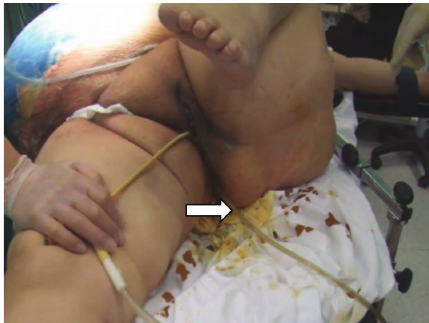
Figure 4: Intrarectal NPT was shown by